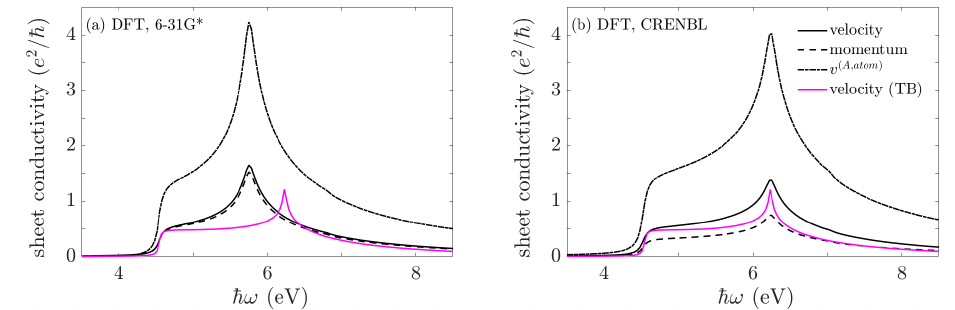
Figure 3: Frequency-dependent sheet conductivity of monolayer hBN as obtained from the evaluation of Eq. (29) using (a) a all-electron and (b) small-core pseudopo- tential DFT calculations. The calculation with a first-neighbour tight-binding model is included in both panels. See Fig. 1 for the corresponding band structures.